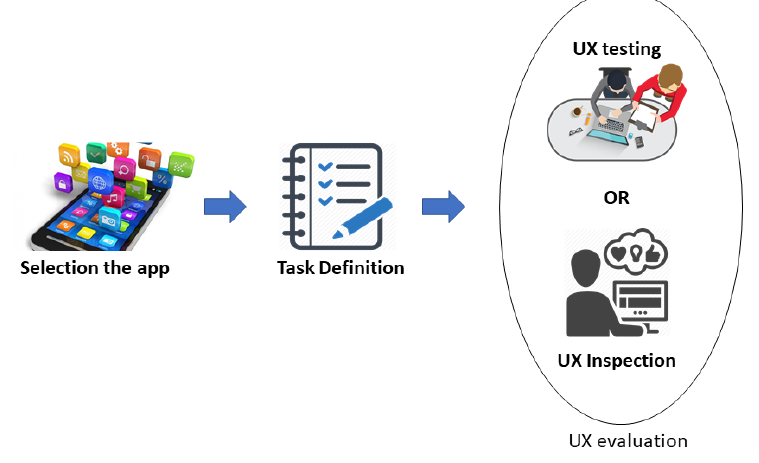
Figure 2. The UX-Tips evaluation